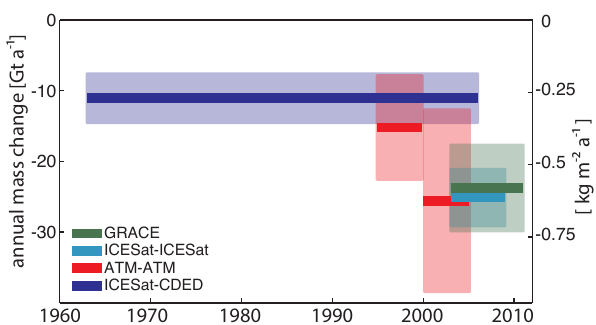
Fig. 8. Mass changes of Baffin and Bylot Island glaciers with cor- responding 95% confidence intervals.